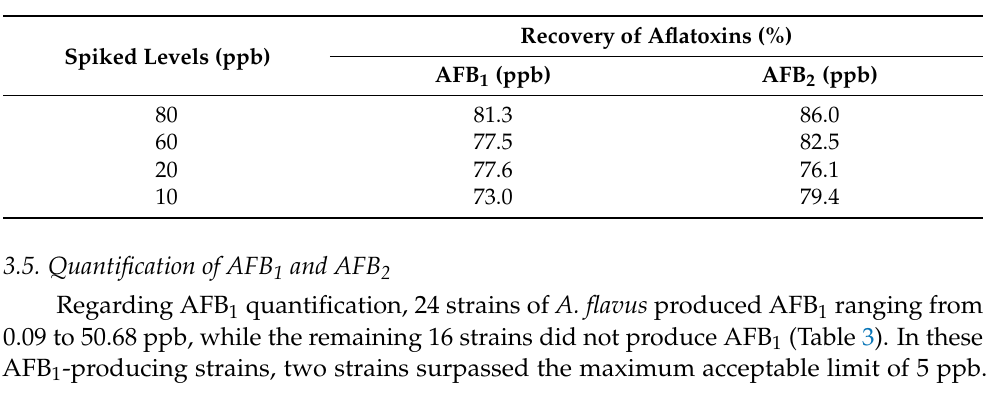
Figure 4. Calibration curves of standard solutions of AFB 1 ( A ) and AFB 2 ( B ) concentrations of 10, 20, 60, and 80 ppb as detected by FLD.